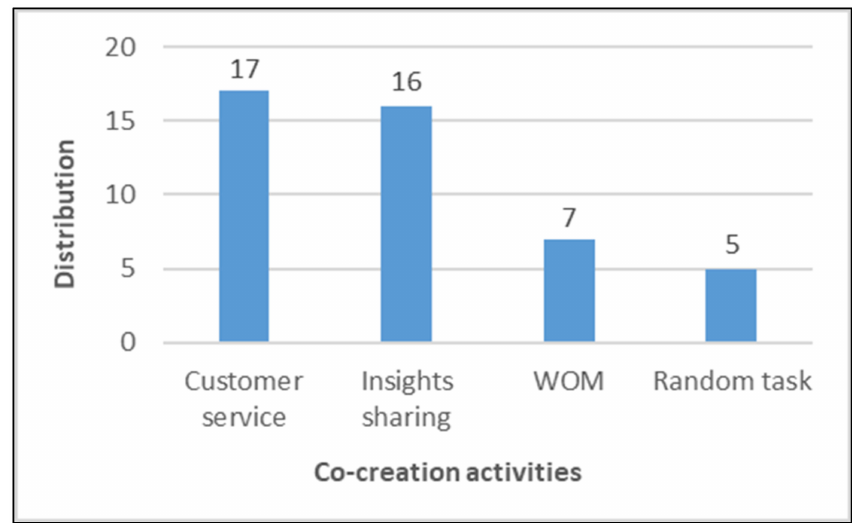
Figure 1. Distribution of co-creation activities across the surveyed case studies.